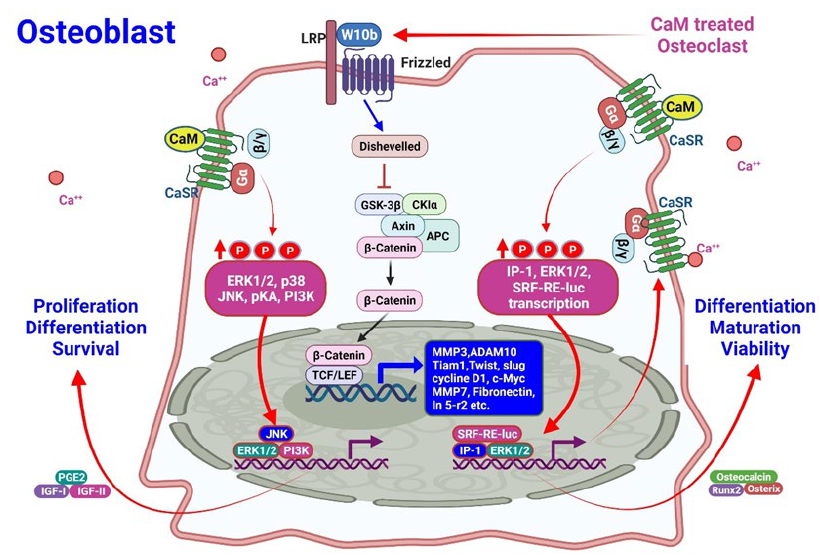
Figure 3. The molecular mechanism underlying the effects of CaMs on osteoblasts in CKD. The Wnt-10b released from osteoclasts by CaMs activates β -catenin by inhibiting GSK-3 β -mediated degrada- tion. On the other hand, nuclear Erk1/2 phosphorylation activated by CaMs activates the transcrip- tion, along with c-Jun N-terminal kinase (JNK)/PI3K, which increases osteoblast proliferation and maintains survival. The activation of Erk1/2 with serum response factor-response element (SRF-RE)- luc and insulin-like growth hormone factor is responsible for osteoblast proliferation/survival and differentiation and its maturation.